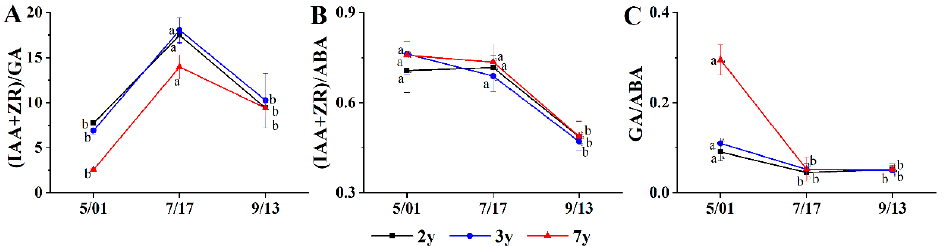
Figure 2. Changes in endogenous hormones ratios during the growth of G. uralensis Fisch. The different letters reflect significant differences among different indexes in the same stage e: ( A ) (IAA+ZR):GA, ( B ) (IAA+ZR):ABA, and ( C ) GA:ABA.